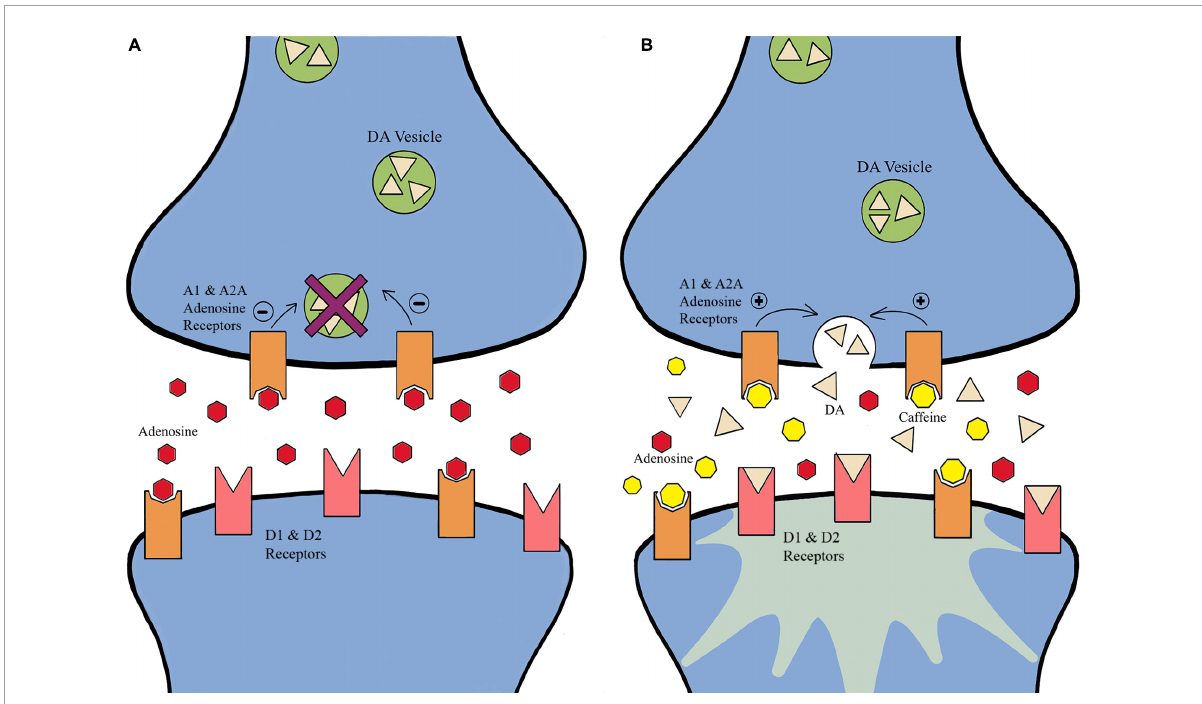
FIGURE2 The effects of caffeine on adenosine receptors. (A) Adenosine binds to adenosine receptors and inhibits dopamine activity. (B) Caffeine acts as an antagonist where it blocks adenosine binding to adenosine receptors, enhancing dopamine activity. The mechanism increases neuron excitability, promotes neurotransmitter release, increase brain activity, and may improve spinal and supraspinal excitability (Fredholm et al., 1999; Smith, 2003; Hogervorst et al., 2008; Connell et al., 2016; Pires et al., 2018; Saville et al., 2018; Shabir et al., 2018; Franco-Alvarenga et al., 2019; Huertas et al., 2019; Cipollone et al., 2020; Machado et al., 2020; Sanchis et al., 2020; Wang et al., 2020; Lorenzo Calvo et al., 2021; Vázquez et al., 2022; Ágoston et al.,